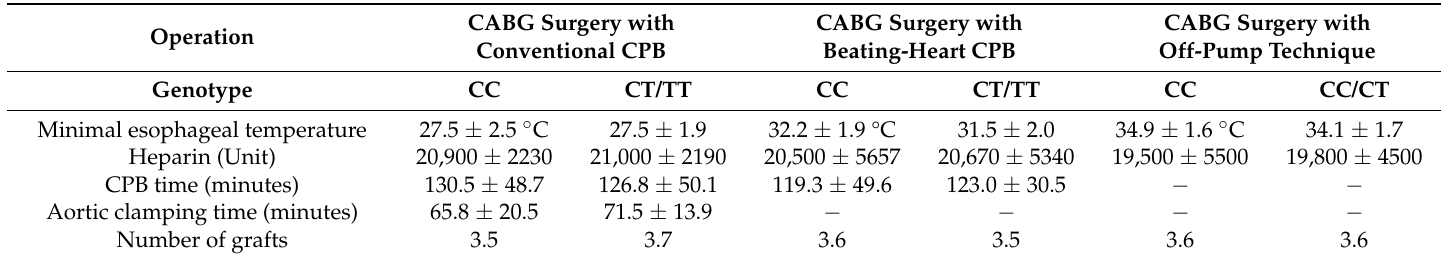
Table 3. Perioperative characteristics ( n = 347) in elective CABG